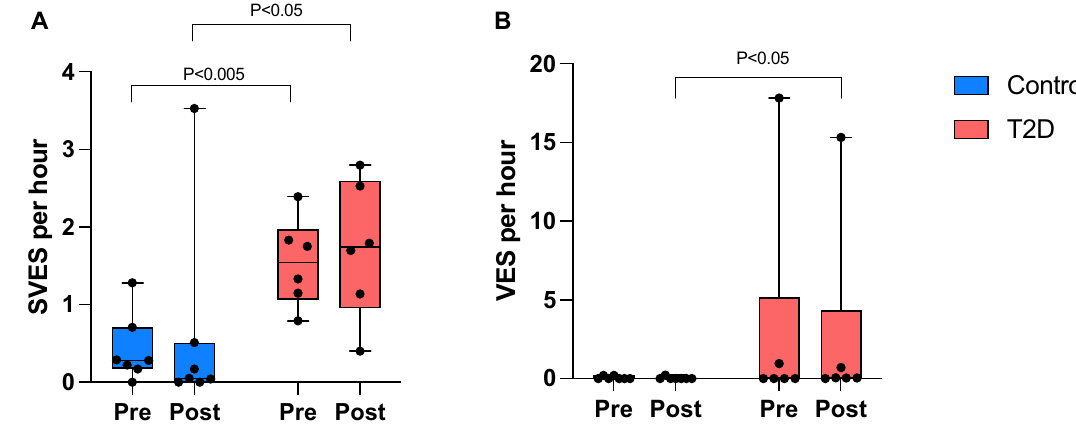
Figure 3. Holter electrocardiography. ( A ) Supraventricular extrasystoles (SVES) per hour (Control: n = 7, T2D: n = 7) and ( B ) ventricular extrasystoles (VES) per hour (Control: n = 7, T2D: n = 6). Data presented with box and whiskers with minimum to maximum values. Pre represents the complete period 24 h before exercise and Post represents the complete period 24 h after termination of exercise. No statistical differences within groups from pre- to post-exercise was observed. p values are